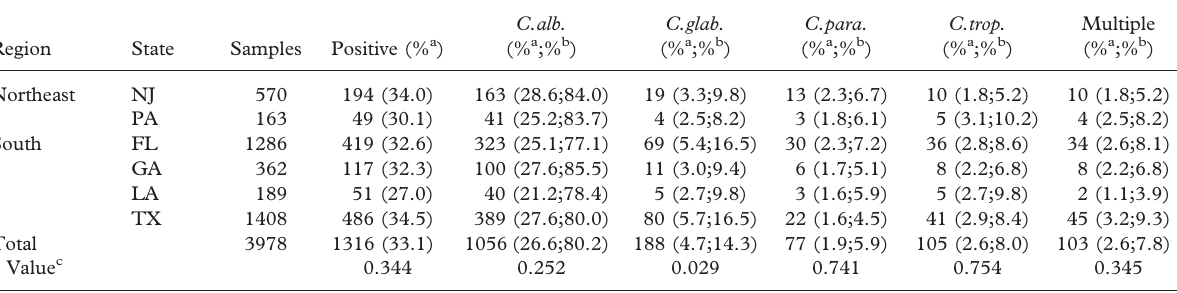
Table I Distribution of samples and detection rate of Candida species by subjects’ state of residence.